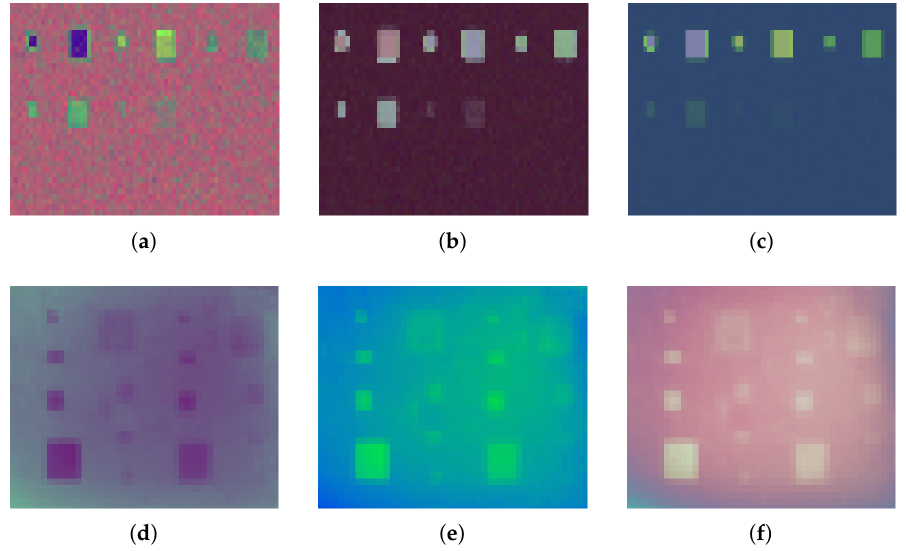
Figure 8. Results obtained with the application of QFT processing to the sequence colorized by Gaussian KPCA: ( a ) σ = 0.01, direction 15 and frame 1, ( b ) σ = 0.05, direction 63 and frame 7, ( c ) σ = 0.5, direction 54 and frame 17, ( d ) σ = 5, direction 26 and frame 3, ( e ) σ = 5, direction 66 and frame 1, ( f ) σ = 1, direction 67 and frame